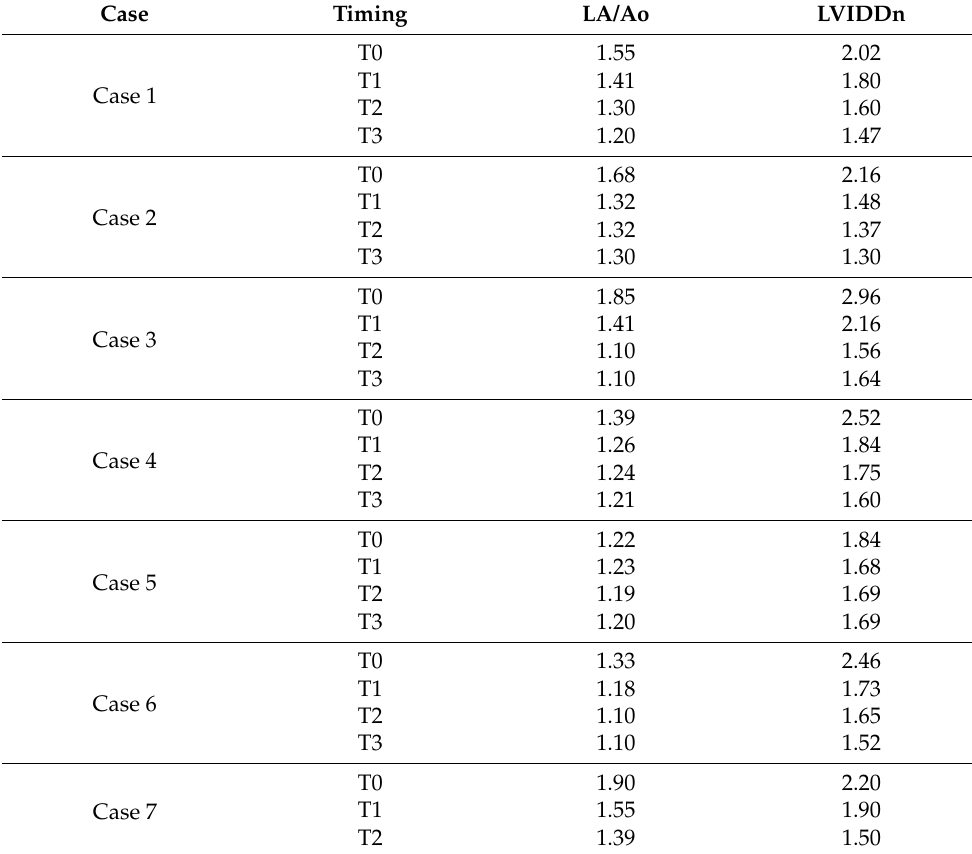
Table 2. Echocardiographic measurements before transvenous Amplatzer Vascular Plug II occlusion (T0) and at 24 h (T1), one week (T2), and three-month check-ups (T3).